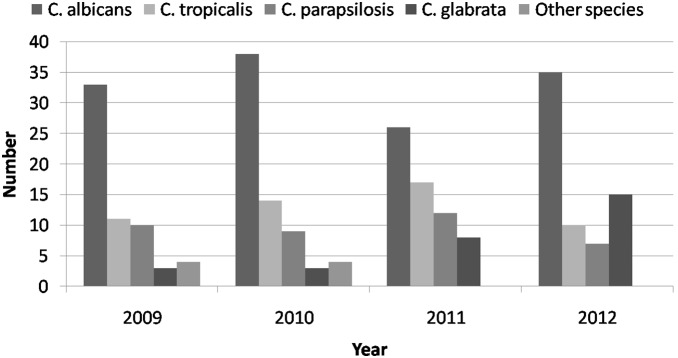
The trend of Candida species distribution with year.